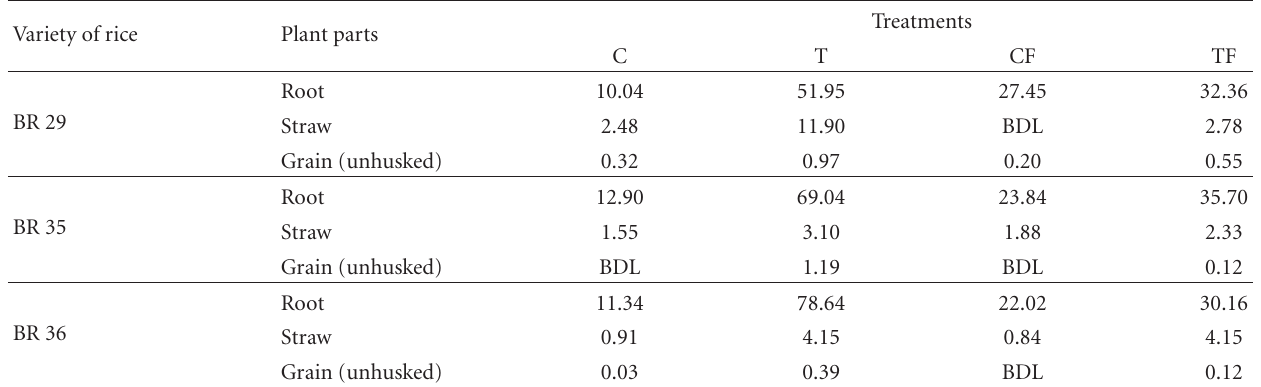
Table 5: Concentration of As (mg kg − 1 ) in boro rice